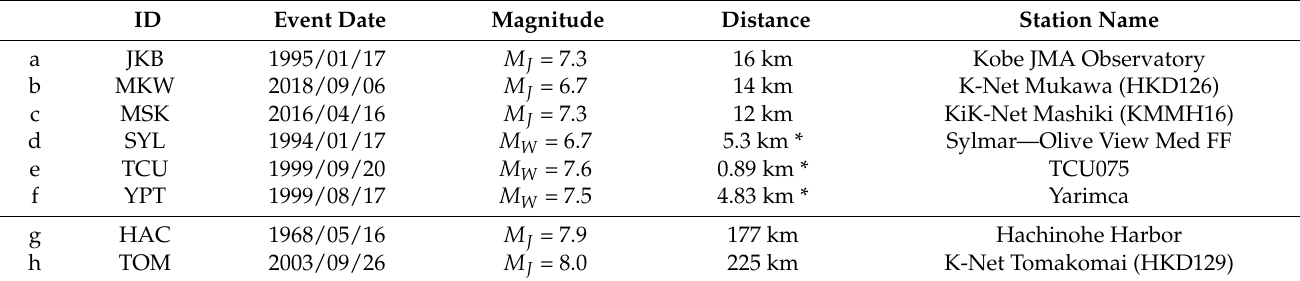
Table A1. Event date, magnitude, location of epicenter, distance, and station name of each